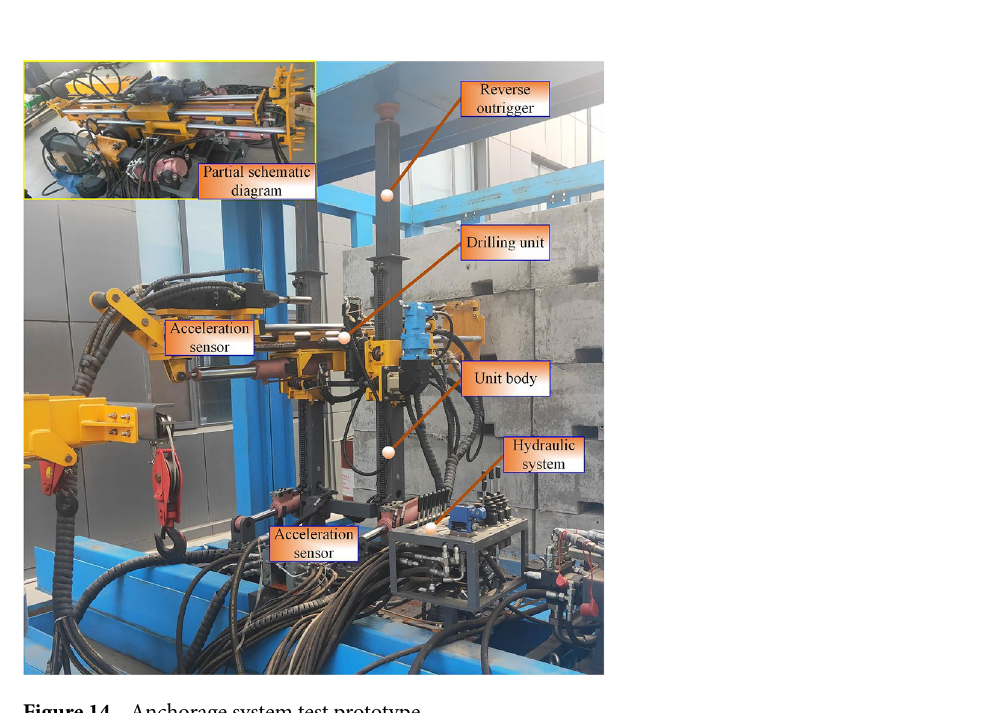
Figure 13. Vibration displacement diagram of drill pipe under different drilling incident angles.